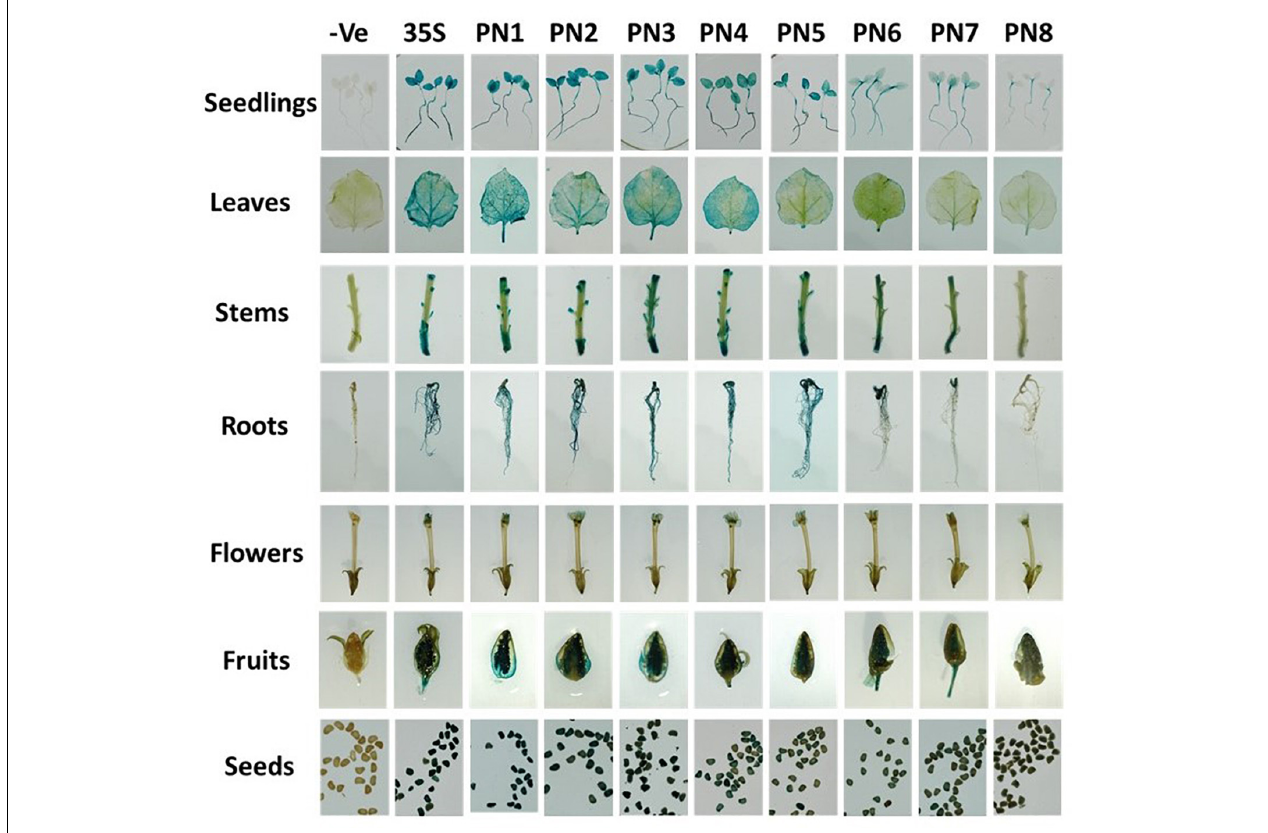
FIGURE 3 | Histochemical GUS staining in tissues of T 3 transgenic N. benthamiana . Plant organs from homozygous T 3 generation transgenic lines were incubated in GUS staining solution for 24 h at 37 ◦ C. Then the samples were observed and photographed after